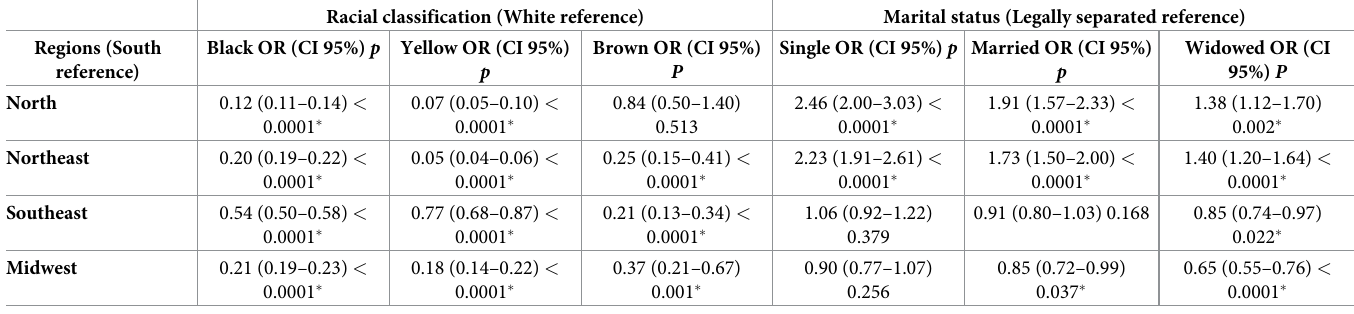
Table 1. Sociodemographic factors that predict mortality in Brazil in relation to the largest category. Racial classification (White reference) Marital status (Legally separated